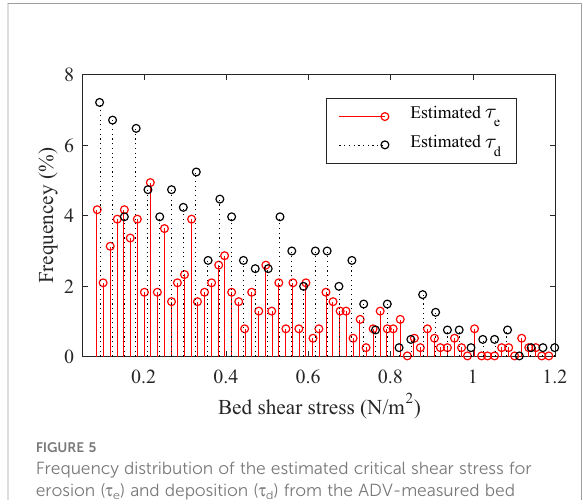
FIGURE 5 Frequency distribution of the estimated critical shear stress for erosion ( t e ) and deposition ( t d ) from the ADV-measured bed level